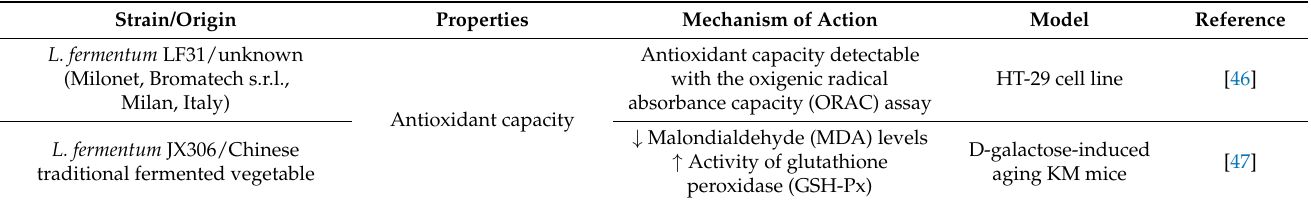
Table symbols: ↓ Reduction and ↑ increase. Table 2. Effects of different L. fermentum strains in clinical trails.